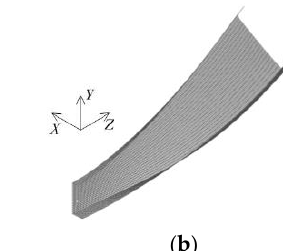
and SD beam models are decreasing as the slenderness ratio increases.